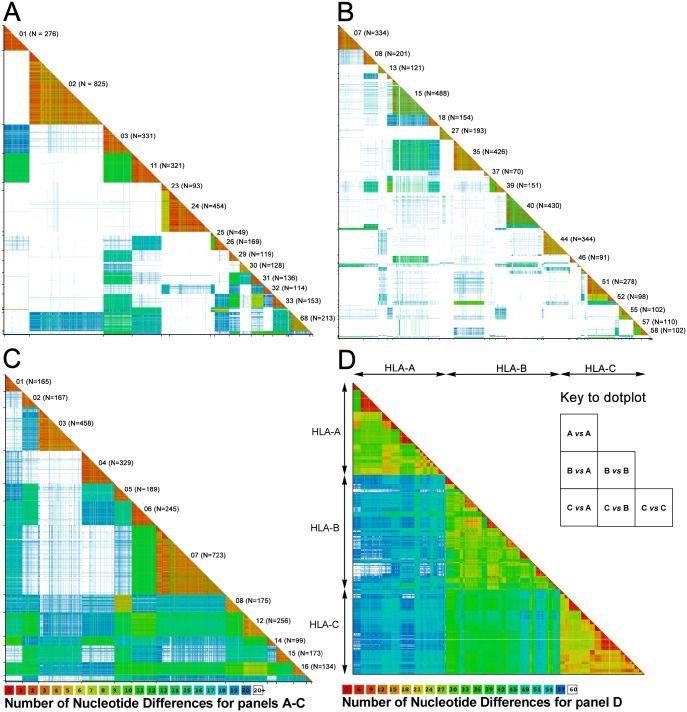
Pairwise comparison defines allele groups with high sequence similarity.The dot plots show the results of pairwise comparison of nucleotide sequences within HLA-A, (Panel A) HLA-B
(Panel B) HLA-C (Panel C) and all three combined (Panel D). A color scale indicates the number of nucleotide differences in each pair compared with red representing the most closely related alleles. The diagonal labeling in the individual gene plots indicates the allele groups, i.e. 01 in panel A is HLA-A*01, N indicates the number of alleles in each group that were used in the analysis. The diagonal labels do not show the following groups where N is less than 25: A*34, A*36, A*43, A*66, A*69, A*74, A*80, B*42, B*45, B*47, B*49, B*50, B*54, B*59, B*67, B*73, B*78, B*81, B*82, B*83 and C*18.